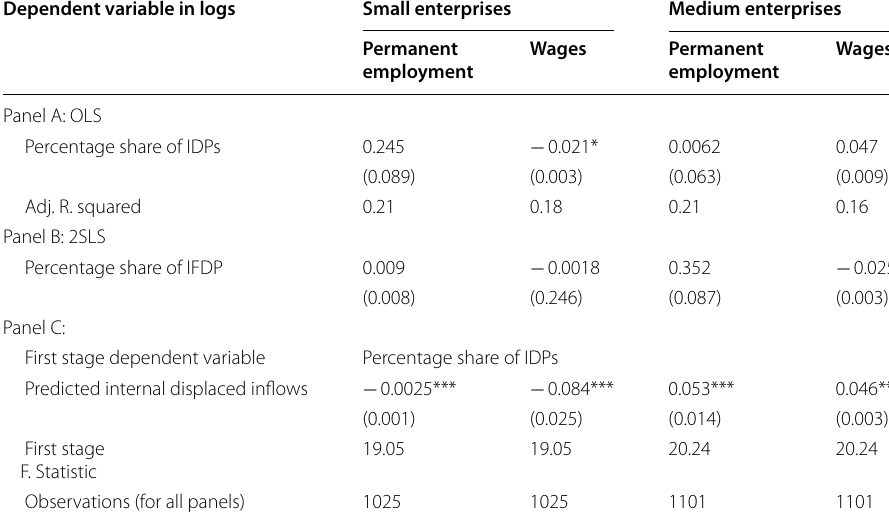
Each coefficient corresponds to a separate regression and all panels include controls for zone and year fixed effects. The standard errors clustered at the zonal level are shown in the parenthesis. *** Represents the significant level at 1%, ** represents significant at 5% and * represents significance at 10*. The estimate controls age, education and marital